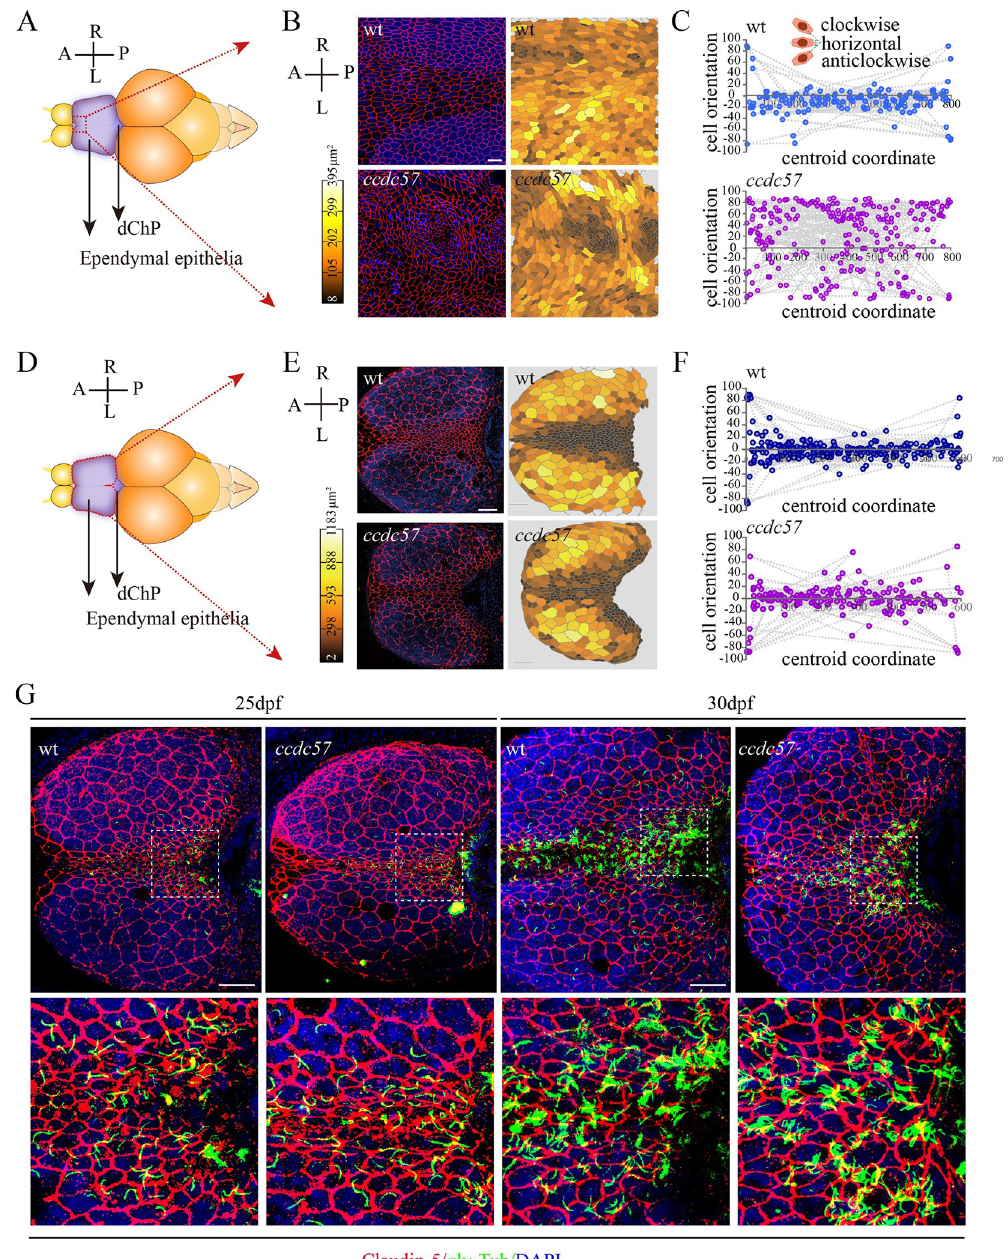
Fig 4. Loss of Ccdc57 results in ependymal cell polarity defects. ( A , B )Distribution pattern of ependymal cells in 3-months- old wild type and ccdc57 mutant as indicated with tight junction marker Claudin-5 staining. Nuclei were counterstained with DAPI in blue. The displayed region of ependymal epithelia was indicated in panel A. Heatmap showing the relative size of each ependymal cells as displayed in the confocal images. ( C )Statistical analysis showing orientation of the midline ependymal cells along the anterior–posterior (A–P) axis in wild type and ccdc57 mutant. The angles between the longer axis of each midline ependymal cells and the A–P axis were used to evaluate cell polarity with 0 degree indicating horizontal cell. ( D , E )Distribution pattern of ependymal cells in the brains of 17 dpf wild type and ccdc57 mutant. ( F )Statistical analysis showing orientation of the midline ependymal cells in wild type and mutant as indicated. ( G )Confocal images showing the ependymal layer labeled with Claudin-5 (red) and glycylated tubulin (green) antibodies in 25 and 30 dpf wt and ccdc57 mutants. Enlarged views of the boxed regions are displayed in the bottom. Nuclei were counterstained with DAPI. Scale bars: 25 μ min panel B; 50 μ min panel E; 50 μ min panel G. The data underlying the graphs shown in the figure can be found in S1 Data.